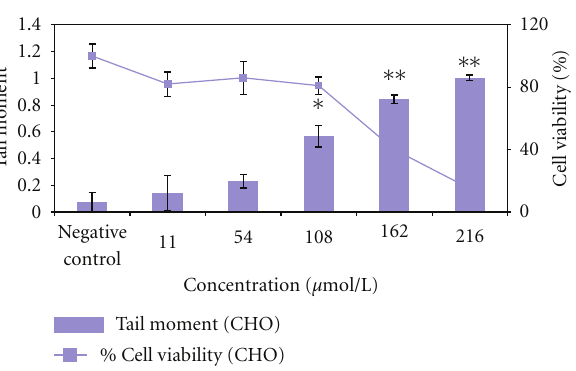
Figure 7: Genotoxicity of Me 3 Bi in CHO-9 cells after 1 h exposure time measured by Comet-Assay. The tests were repeated three times. ∗ P ≤ 0 . 05; ∗∗ P ≤ 0 . 01.